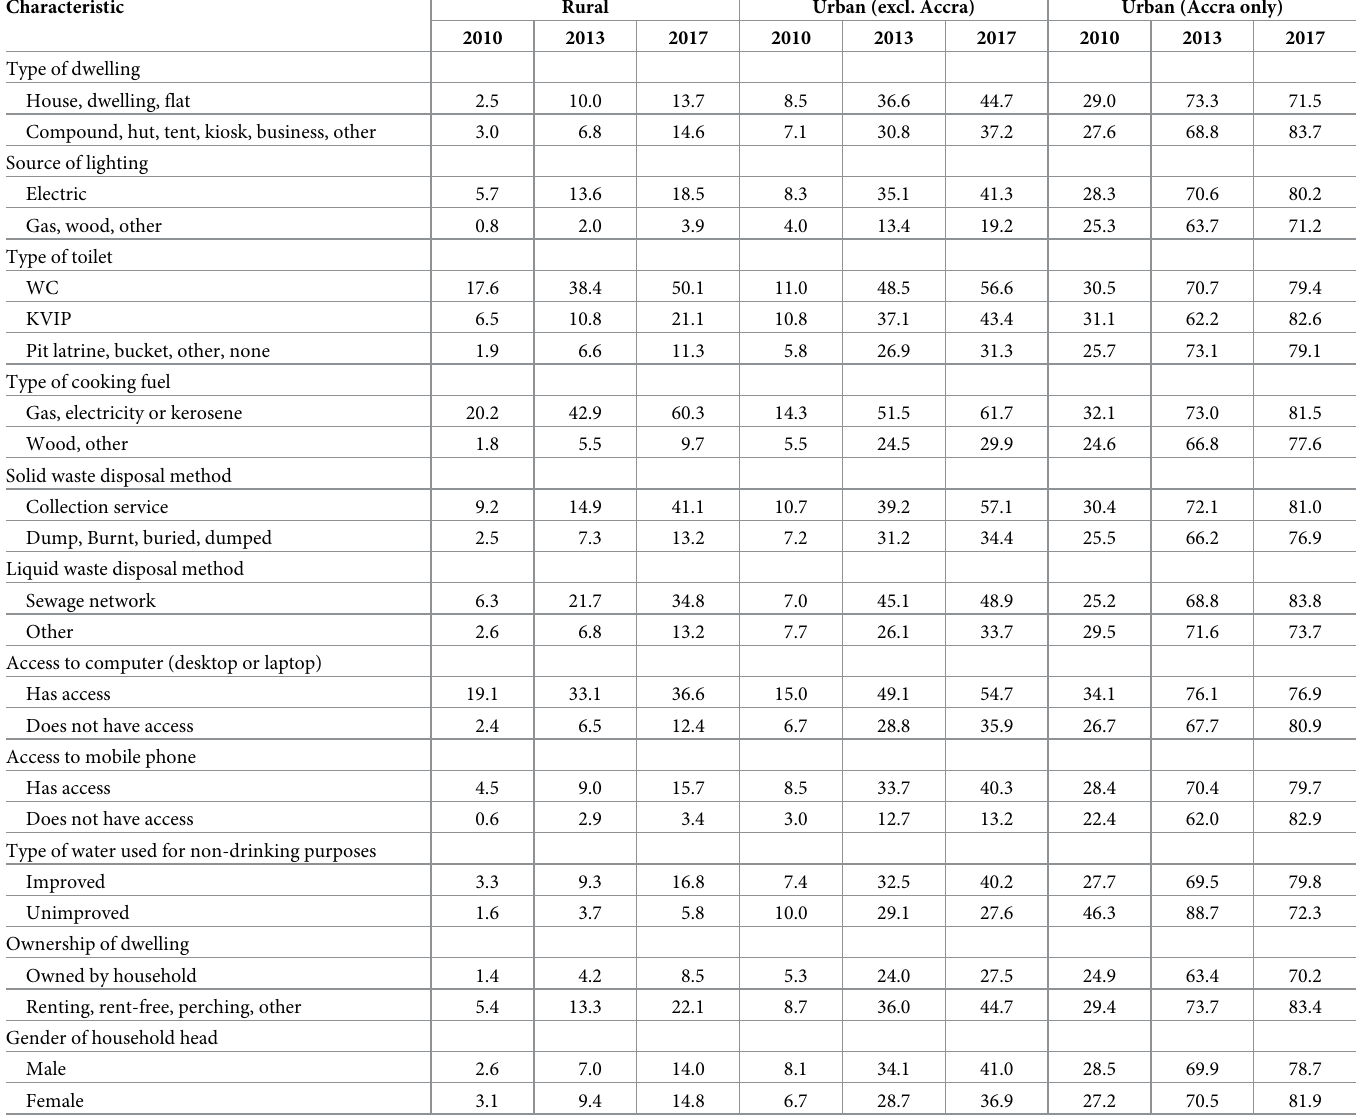
Table 5. Sachet water use among households of different